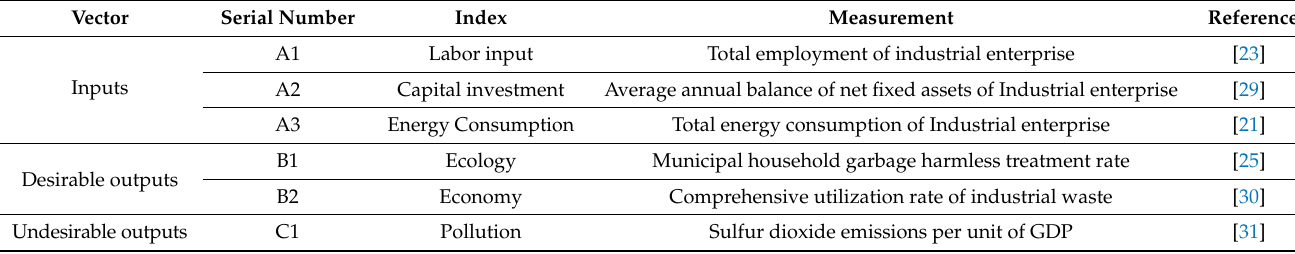
Table 1. GTFP evaluation